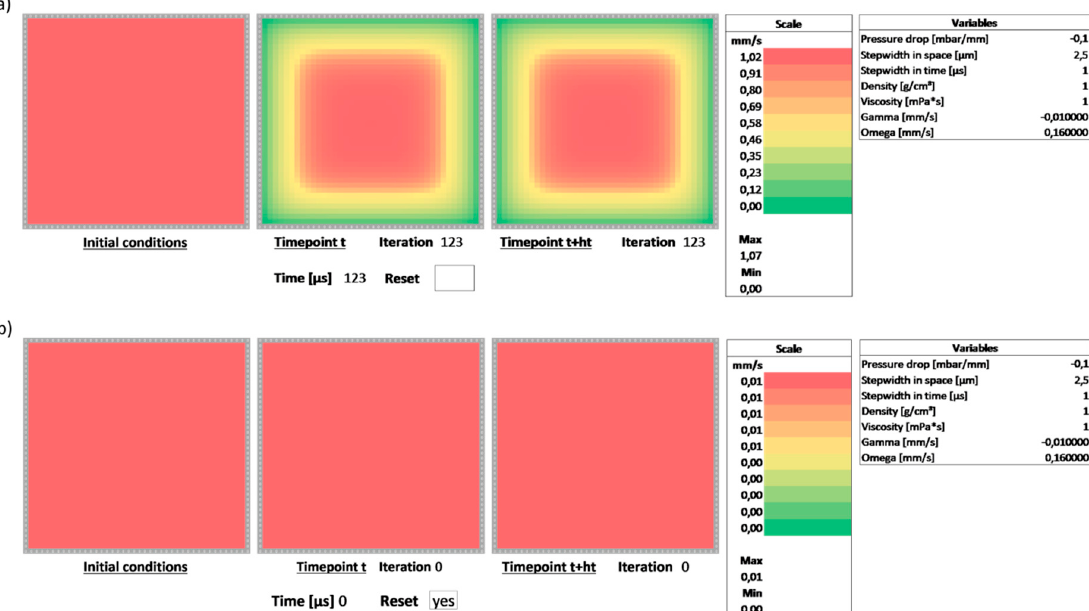
Figure 1. View of the Microsoft Excel spreadsheets with the three panels: initial conditions (left), current time point (center) and next time point (right). ( a ) The evolution of the velocity profile can be observed by pressing the F9 key. The right panel implements Equation (9) and steps forward in time. The values are copied back to the center panel thus performing one iteration. ( b ) By adding any value into the “Reset” field, the scheme is reset, the iteration counter is cleared and the values of the initial condition (left panel) is copied into the center panel thus setting the velocity profile for time point 𝑡 = 0 .